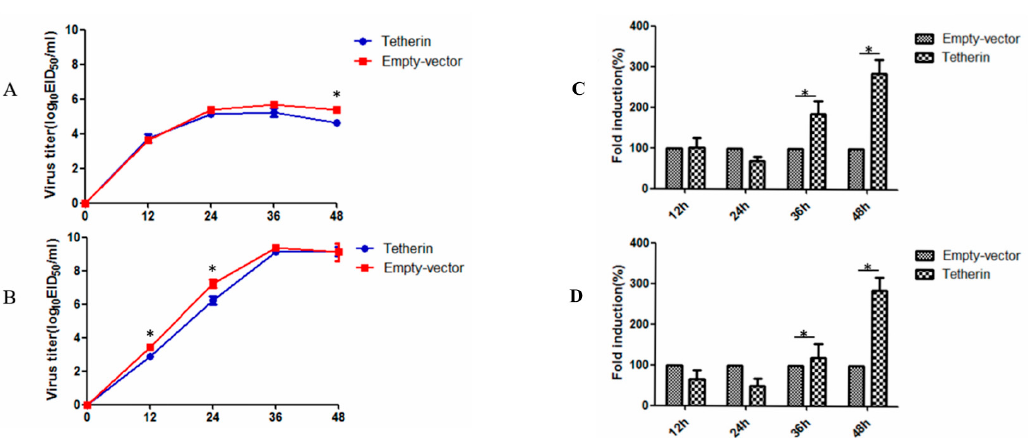
Figure 8. The effect of canine tetherin on CIV production in MDCK cells overexpressing tetherin. ( A ) Replication and growth curve of CIV H3N2; ( B ) replication and growth curve of CIV H5N1; ( C ) the mRNA expression level of CIV H3N2 HA in cells; ( D ) the mRNA expression level of CIV H5N1 HA